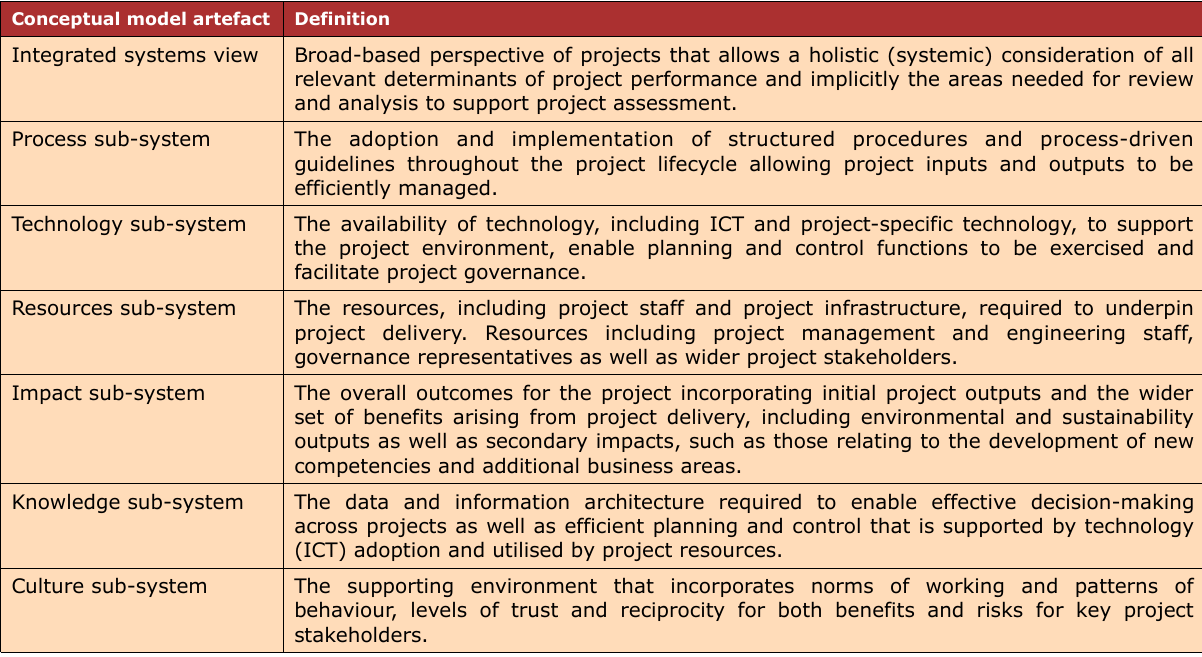
Table 1. Supporting definitions for conceptual